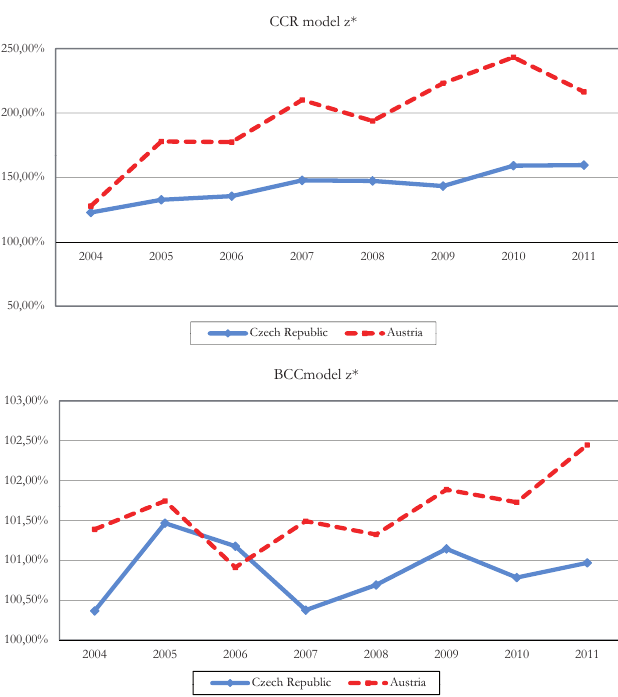
Fig. 2 – Efficiency level measured by CCR and BCC model with undesirable output. Source: Author´s